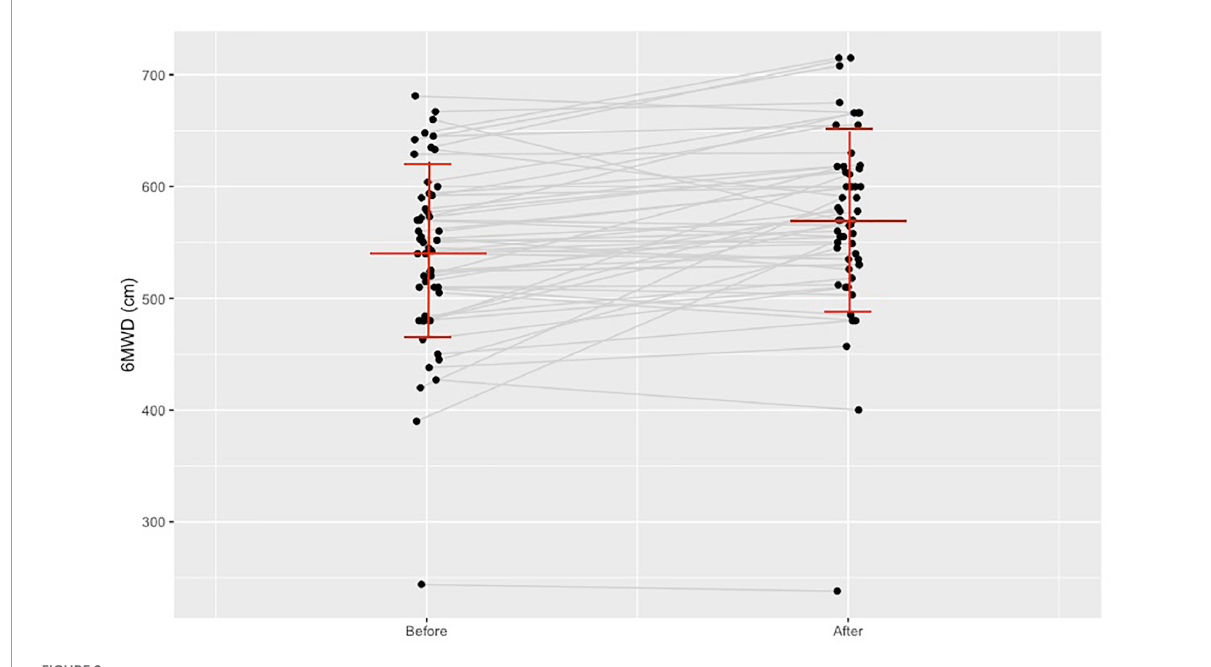
FIGURE2 Change in the 6-min walk distance before and after the training program.